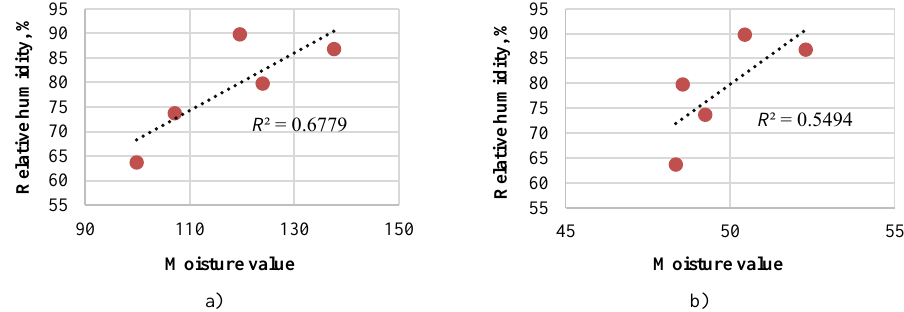
Fig. 8. Correlation between outdoor relative humidity and: a) 2 cm depth measurement values; b) 20 cm depth measurement values. Rain load events with the total amount of rain 1 mm or greater are shown in Fig. 9. Total rain event is greater between 1 st and 2 nd measurement, than between the 2 nd and 3 rd measurements. That could explain the sudden drop of average moisture values in the 3 rd measurements (in 19 th January). Moreover, the 4 th and 5 th measurements, that have shown the highest average moisture values, are made right after the rain